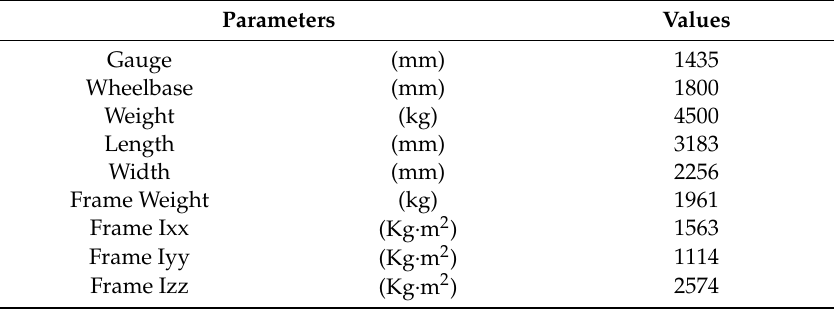
Table 6. The specification of welded bogie frame.